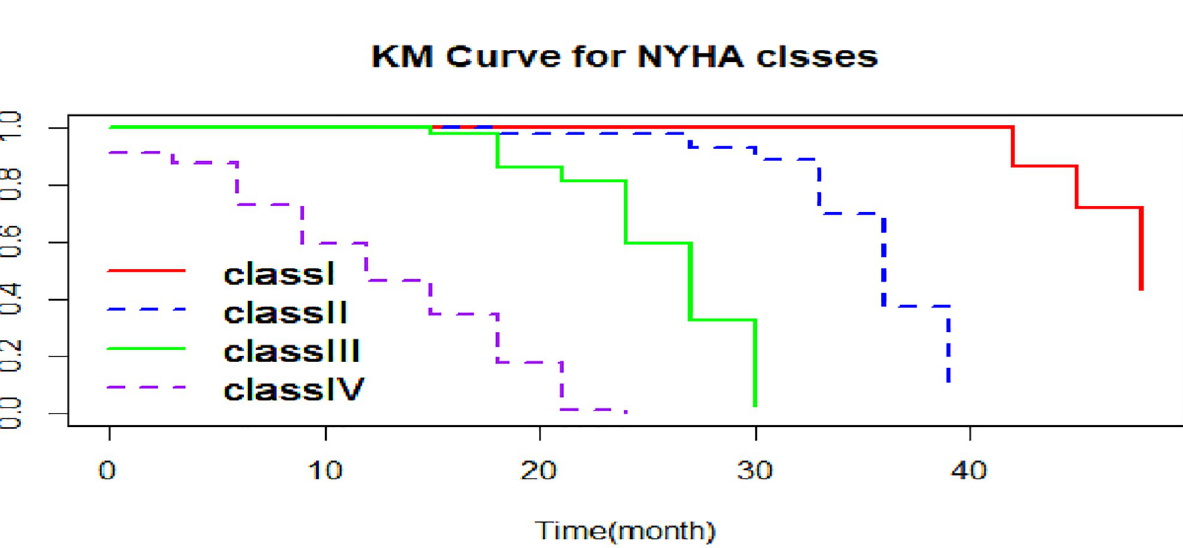
PLOS ONE | https://doi.org/10.1371/journal.pone.0276440 October 20,